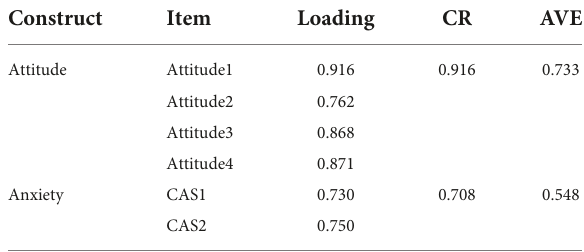
TABLE 2 Full collinearity. TABLE 3 Reliability and convergent validity.